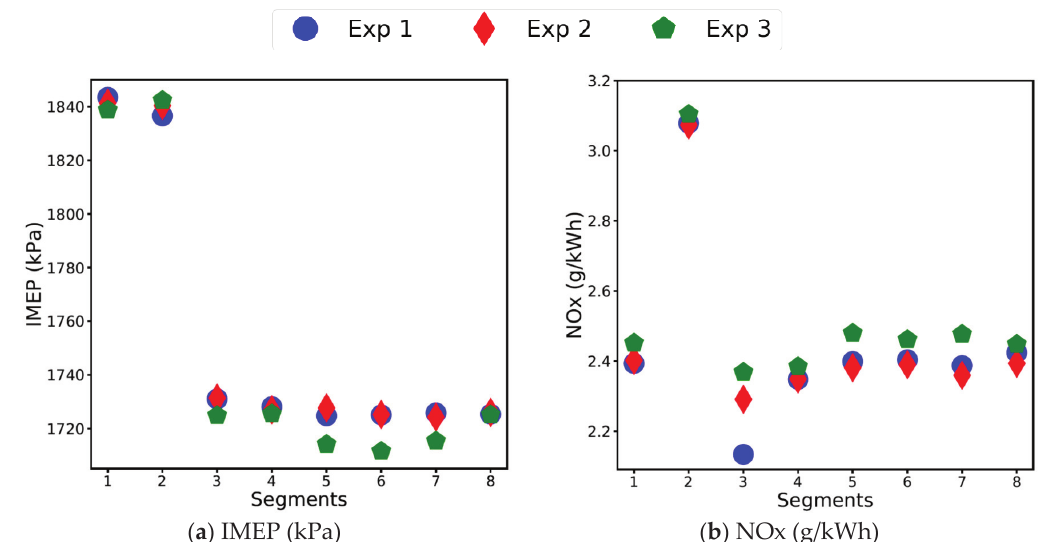
Figure 2. Mean values of indicated mean effective pressure (IMEP) (kPa) ( a ) and NOx (g/kWh) ( b ) at full load in all segments for experiments 1, 2 and 3 at 2000 rpm. The blue circle represents Experiment 1, the red diamond Experiment 2 and the green pentagon Experiment 3.